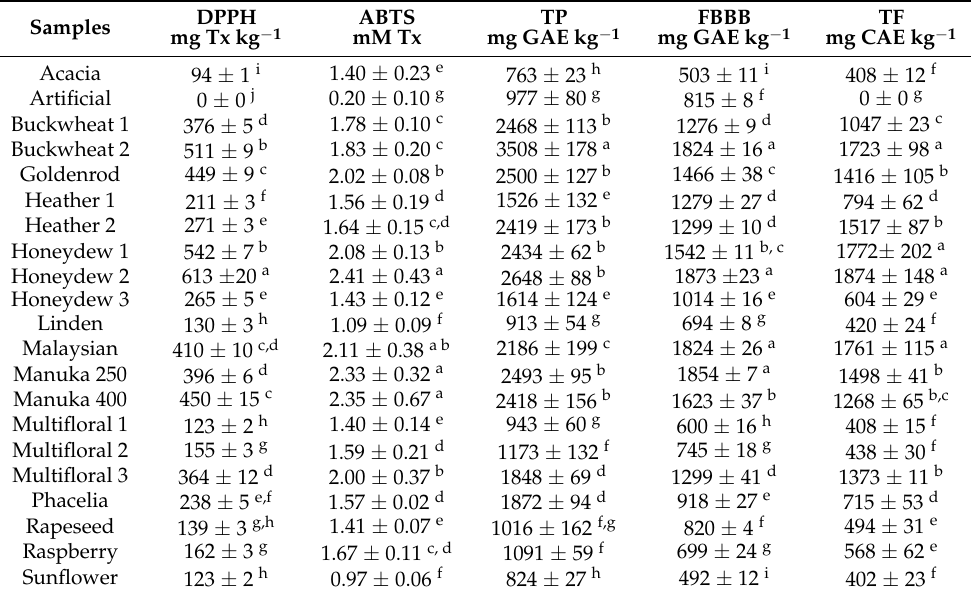
Table 1. Antioxidant properties of the analyzed honeys. Abbreviations: TP, total polyphenol content; FBBB, Fast Blue BB reagent; TF, total flavonoid